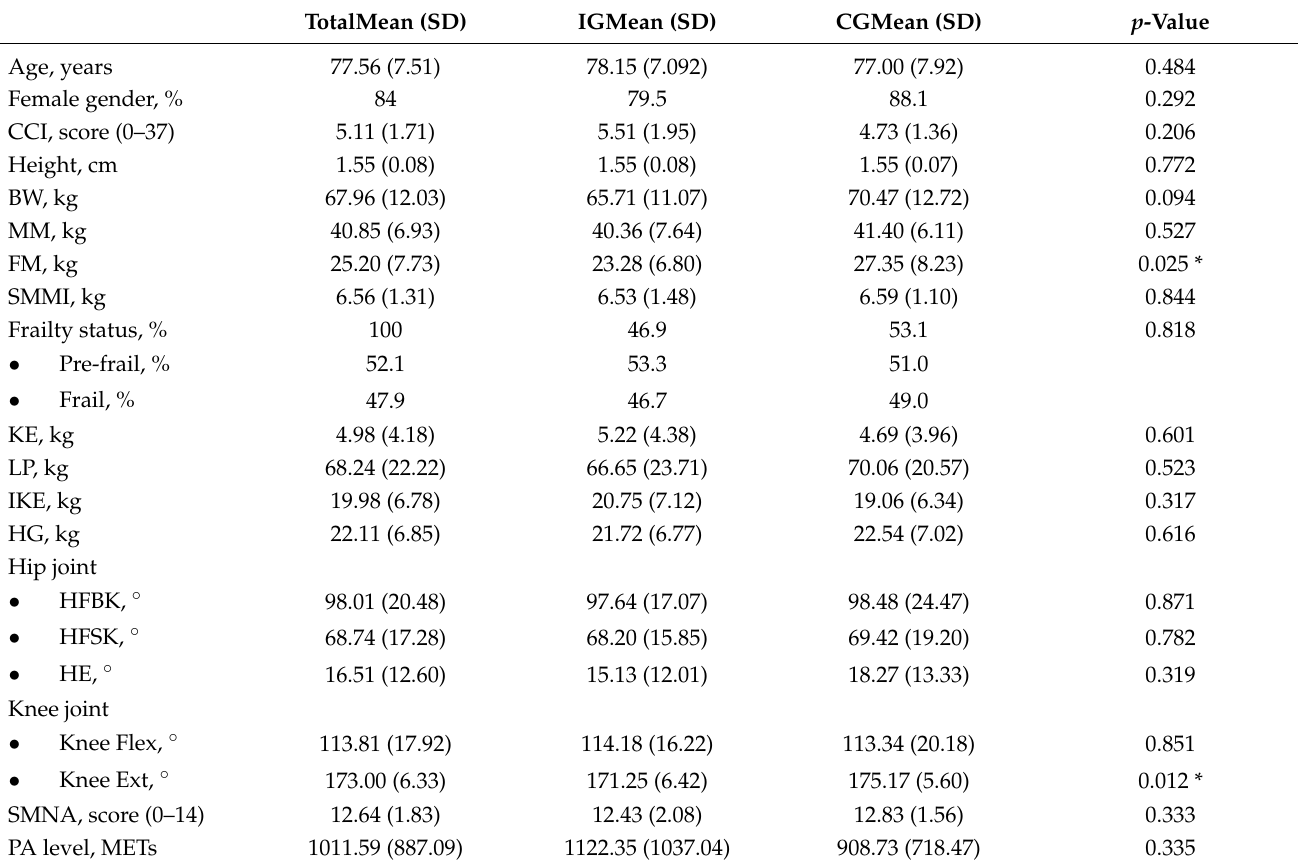
Table 1. Baseline characteristics of the study